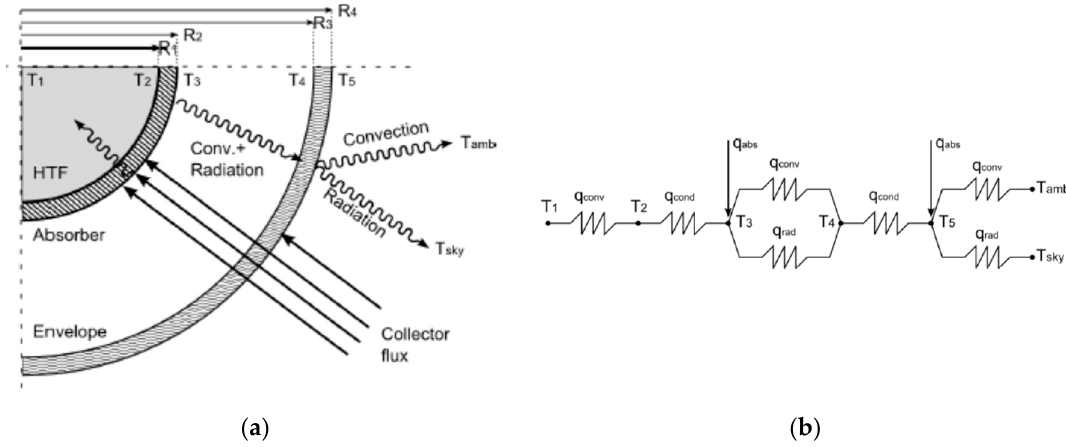
Figure 7. Receiver model: ( a ) thermal energy balance; ( b ) thermal resistance model [59].